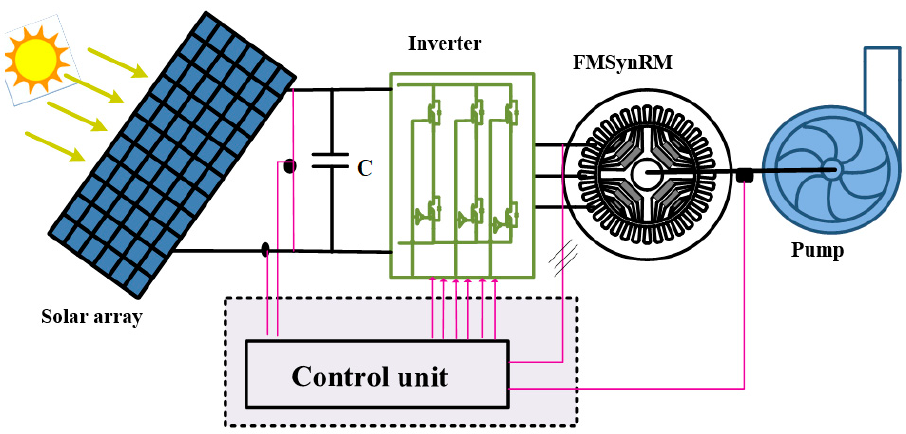
Figure 1. Sketch of the suggested photovoltaic water pumping system